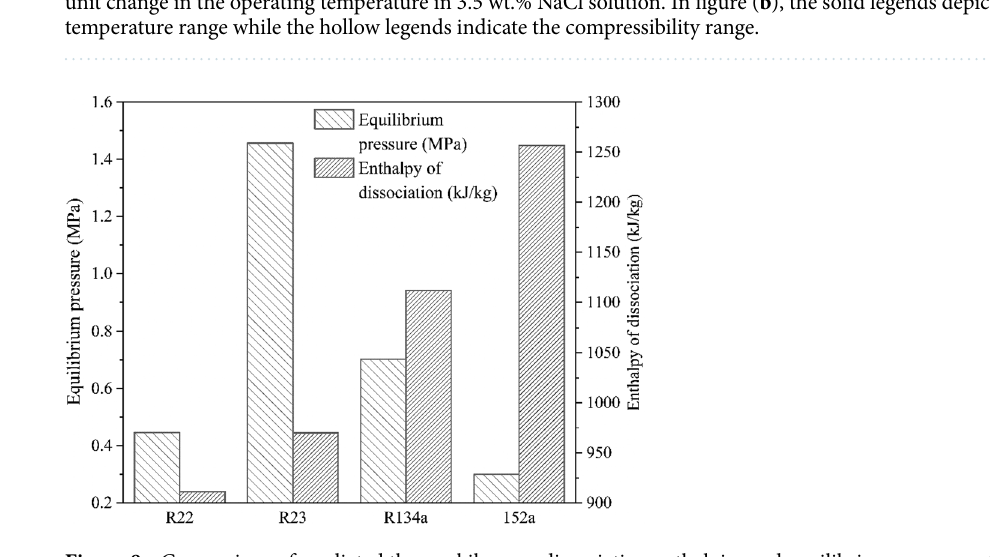
Figure 8. Comparison of predicted the per kilogram dissociation enthalpies and equilibrium pressure of refrigerant formers in 3.5 wt.% NaCl solution at 284